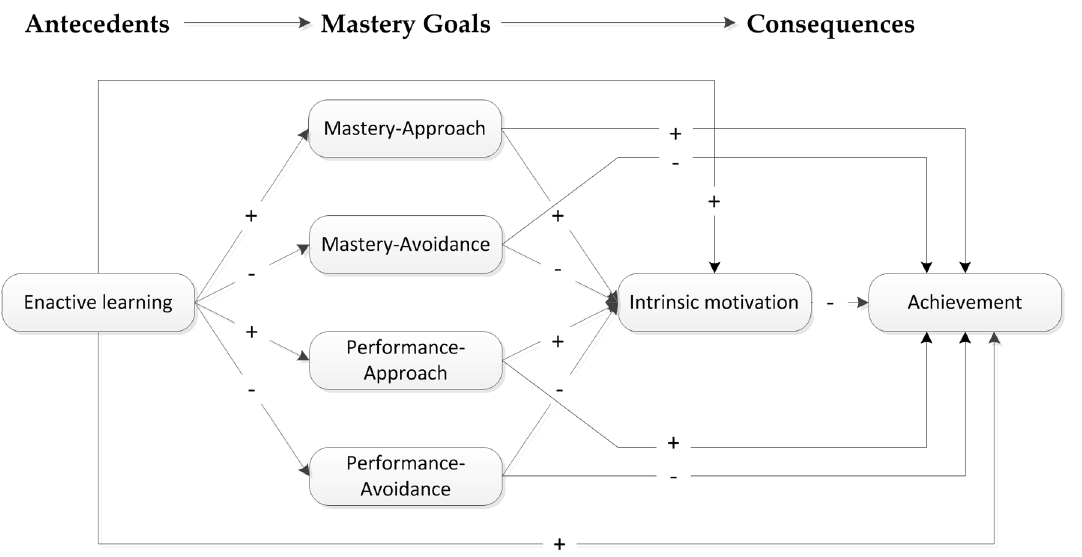
Figure 1. A conceptual model of antecedents and consequences of achievement